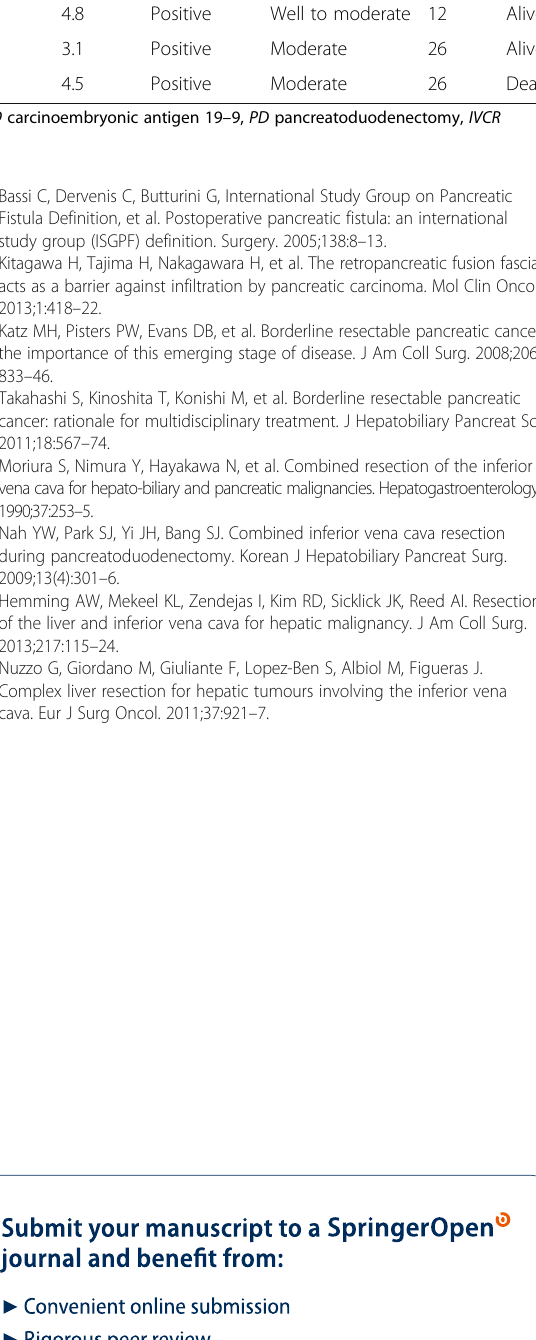
Table 1 Clinical features of three cases of PDAC invading the IVC Case Age, Sex Preoperative Operative years CA19-9, U/ml